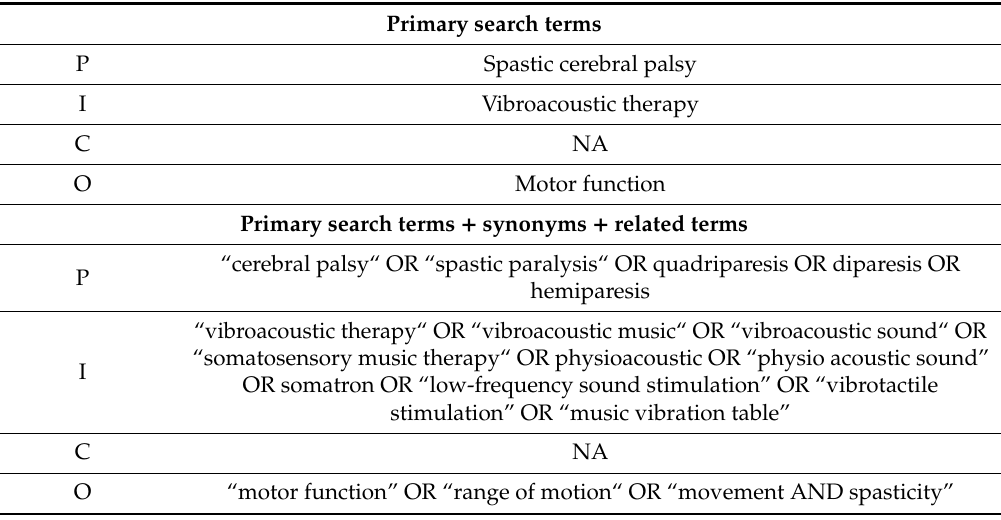
Table 1. Synonymous and related terms for the P–I–O